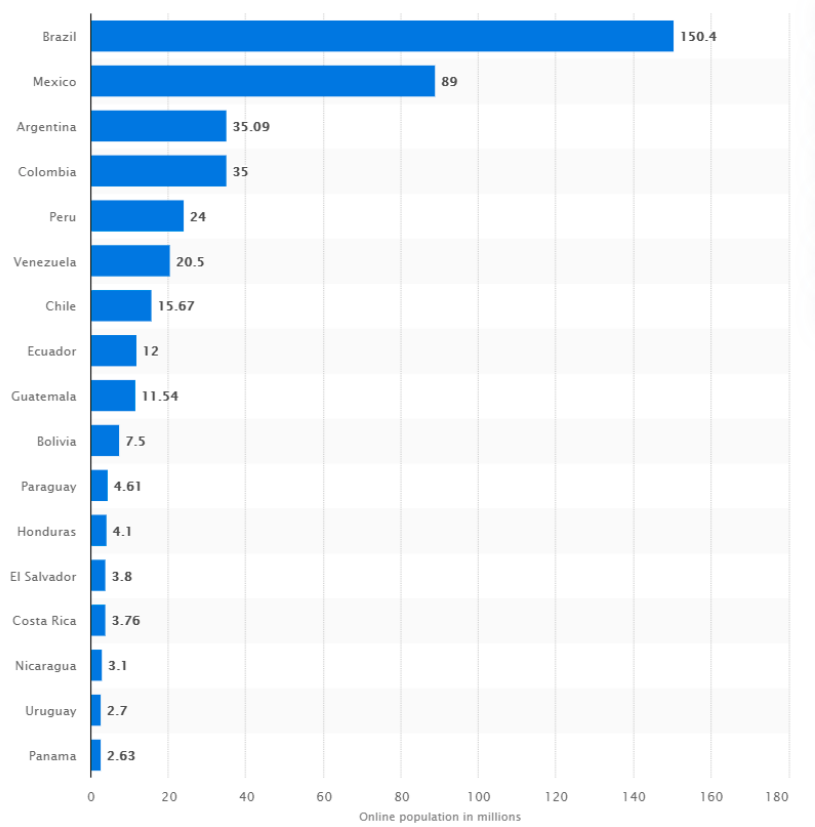
Figure 1. Number of internet users in selected Latin American countries January 2020 (in millions). Source: Statista [38].